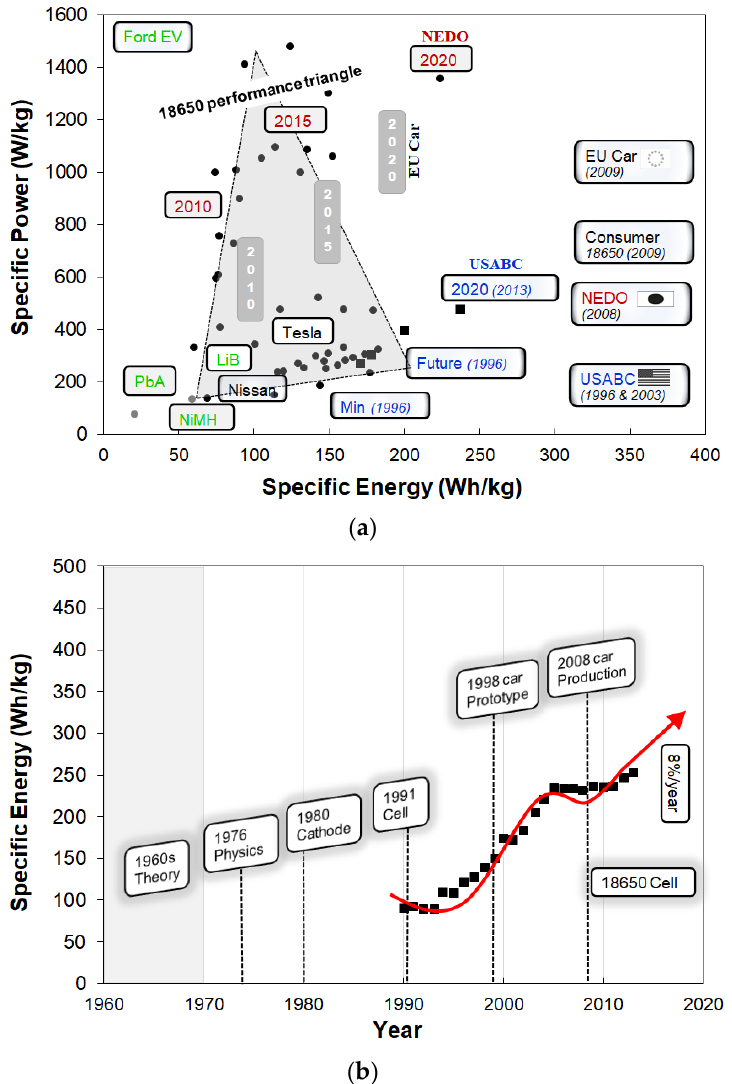
Figure 1. ( a ) EVs and 18650 cell power vs. energy for some commercially available cells under different applications. Adapted with permission from [3]. Copyright 2003 Springer. ( b ) Increase in specific energy of 18650 Li cell thanks to the development over the last 50 years when the intercala- tion/deintercalation of Li was shown. Adapted with permission from [3]. Copyright 2018 Springer.